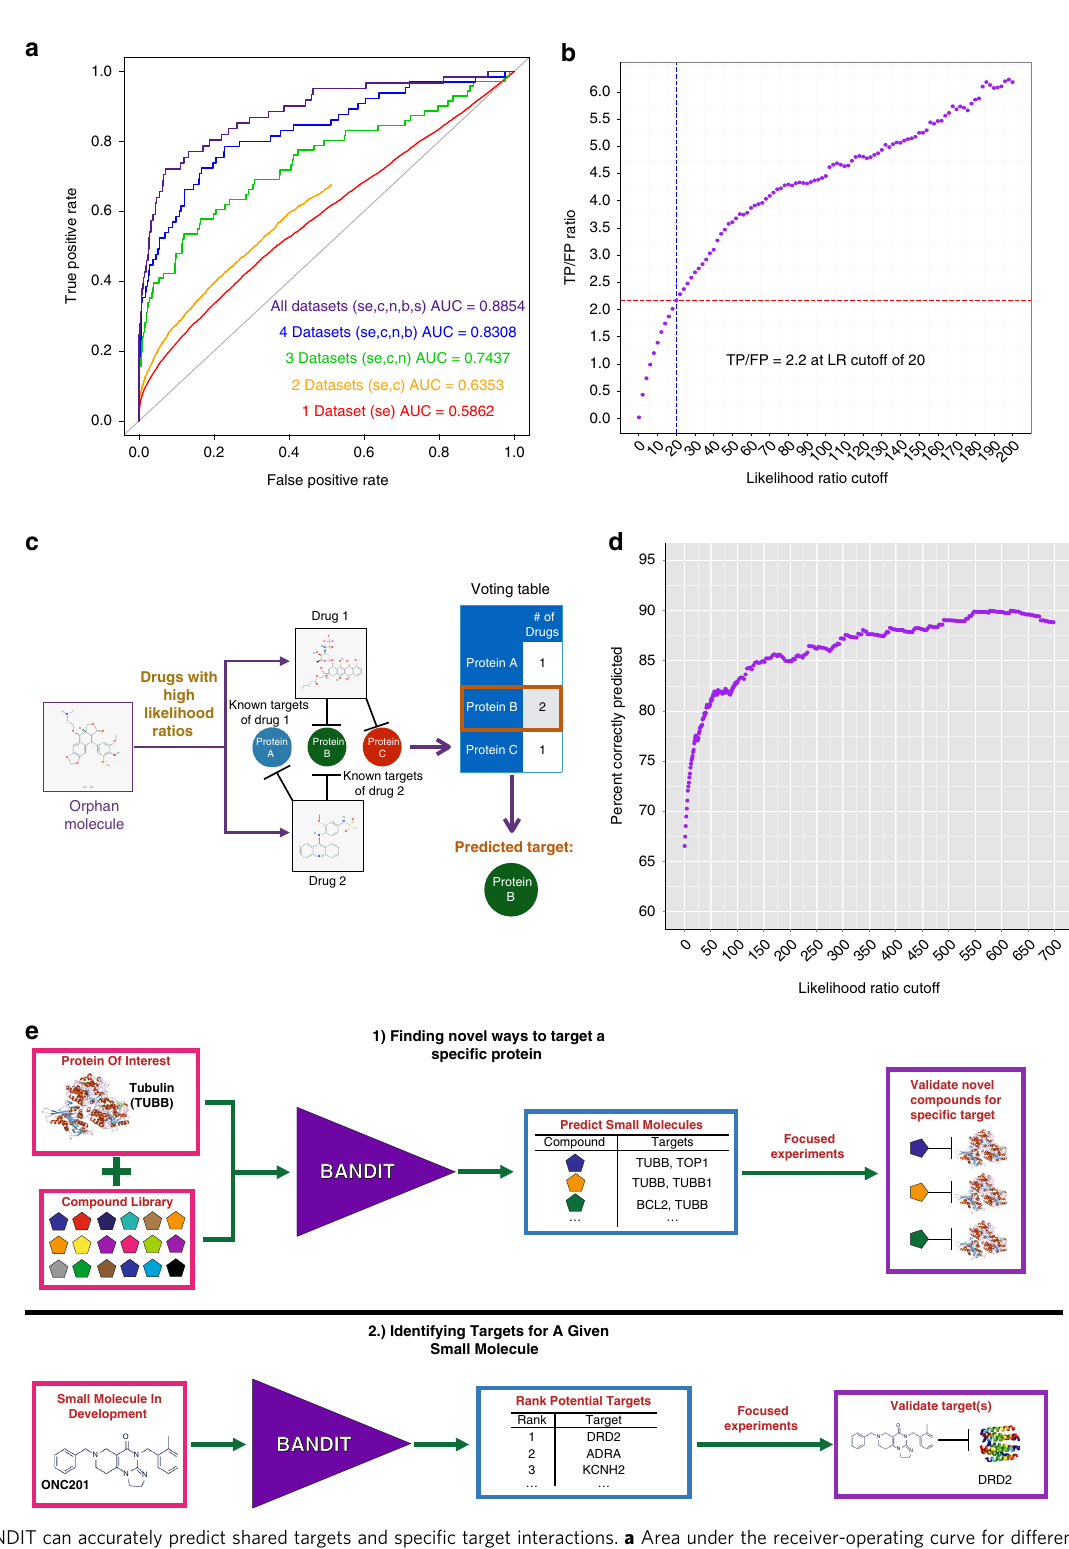
Fig. 2 BANDIT can accurately predict shared targets and speci fi c target interactions. a Area under the receiver-operating curve for different sets of data types. SE = Side effects; C = CMap; N = NCI60; B = Bioassays; S = Structure. b Ratio of true positives to false positives at different likelihood ratio cutoffs. c Schematic of the BANDIT voting schematic for predicting speci fi c target interactions. d Accuracy level of BANDIT ’ s voting algorithm at various likelihood ratio cutoffs. e Schematic of two proposed operating scenarios for